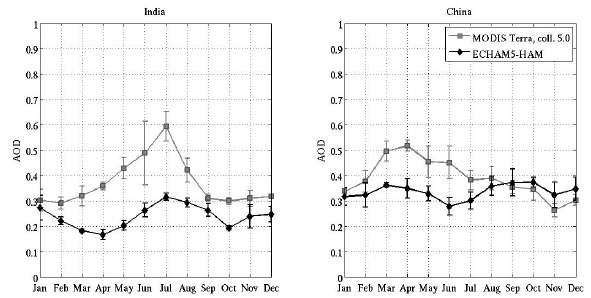
Fig. 13. Monthly mean AOD and interannual variability in MODIS data (gray) and the ECHAM5-HAM simulation (black) in India (left) and in China (right), solid line shows four-year average (2006-2009) and error bars show interannual variability as standard deviation.